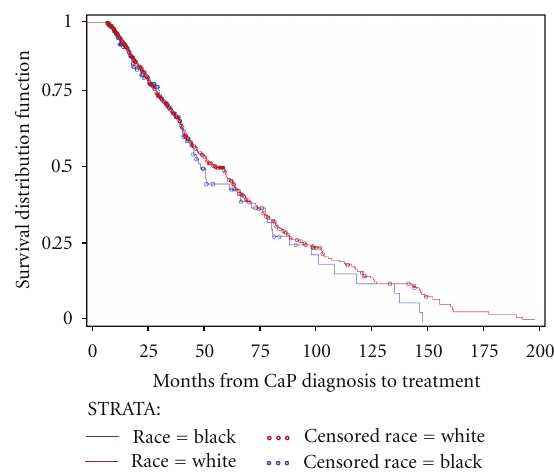
Figure 1: Kaplan Meier unadjusted estimation curve for time to secondary treatment stratified by race among subjects with prostate cancer (CaP) followed on active surveillance (AS) for primary treatment ( N = 886).